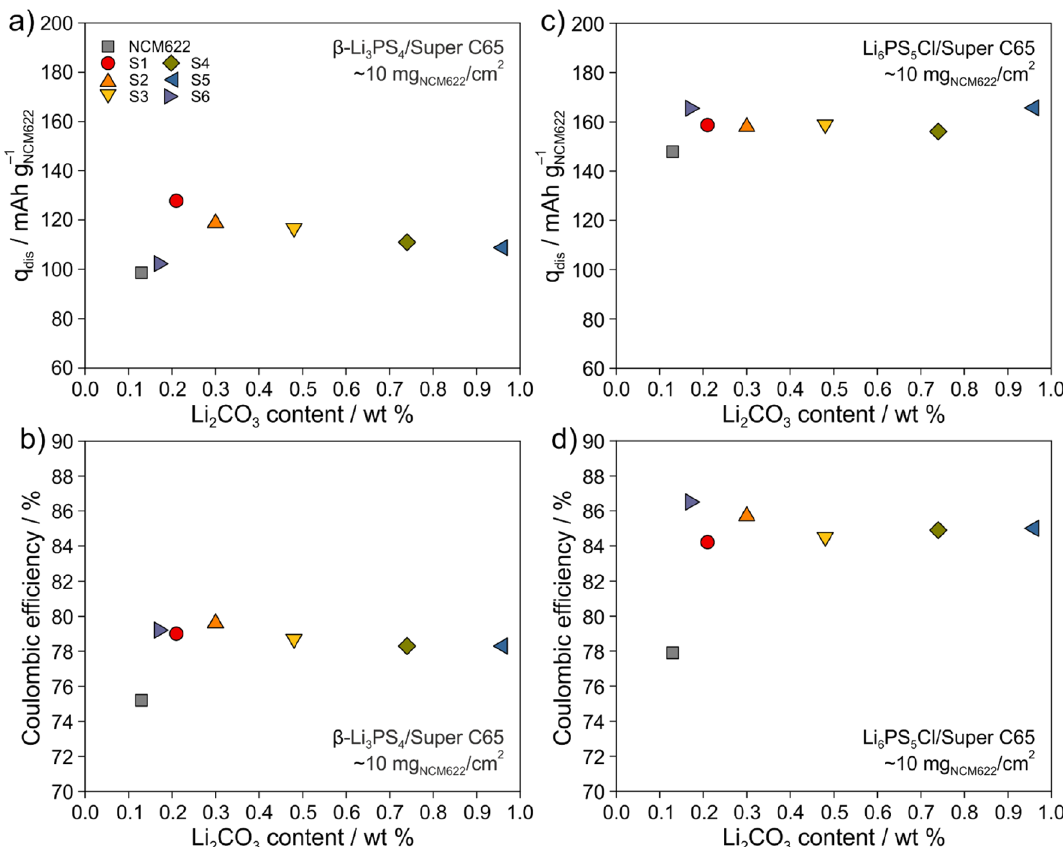
Figure 3. Initial specific discharge capacity and Coulombic efficiency at C/10 rate and 25 °C of SSB cells using the uncoated (pristine) or coated NCM622 cathode materials and ( a , b ) β-Li 3 PS 4 /Super C65 carbon black or ( c , d ) Li 6 PS 5 Cl/Super C65 carbon black. The anode was made of LTO, β-Li 3 PS 4 or Li 6 PS 5 Cl solid electrolyte and Super C65 carbon black